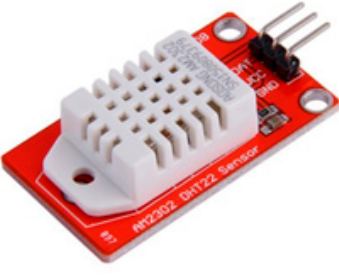
Figure 6. AM2302 DHT22 sensor for light and humidity.